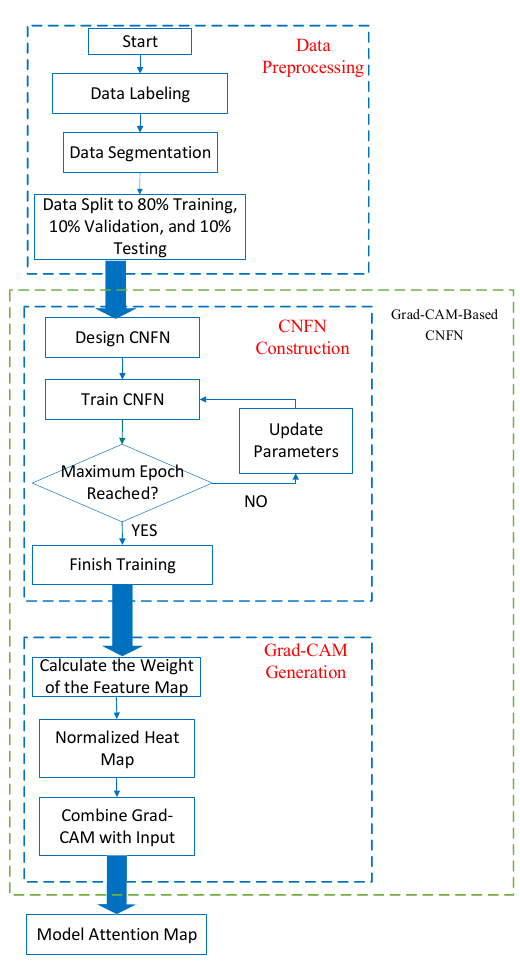
Figure 5. Flowchart of the GC-CNFN.